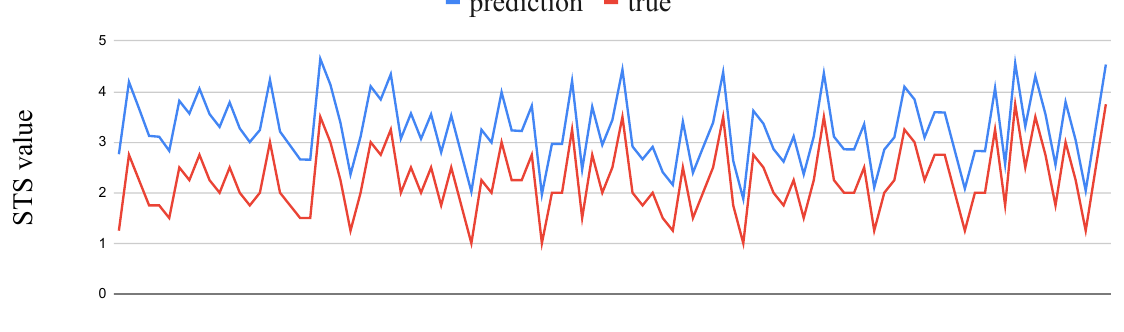
Figure 2. Top 100 examples of ASSIN-PTBR with greater distance between the prediction and true values of the STS task, where such distance is greater than